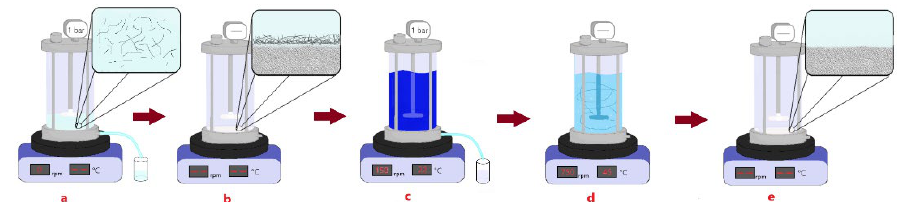
Figure 1. ( a ) Surface coating is performed by filtrating a CNFs solution; ( b ) CNFs are attached to the membrane surface; ( c ) MB retention is tested; ( d ) coating is washed away; ( e ) membrane is free of CNFs and ready for a new coating process.